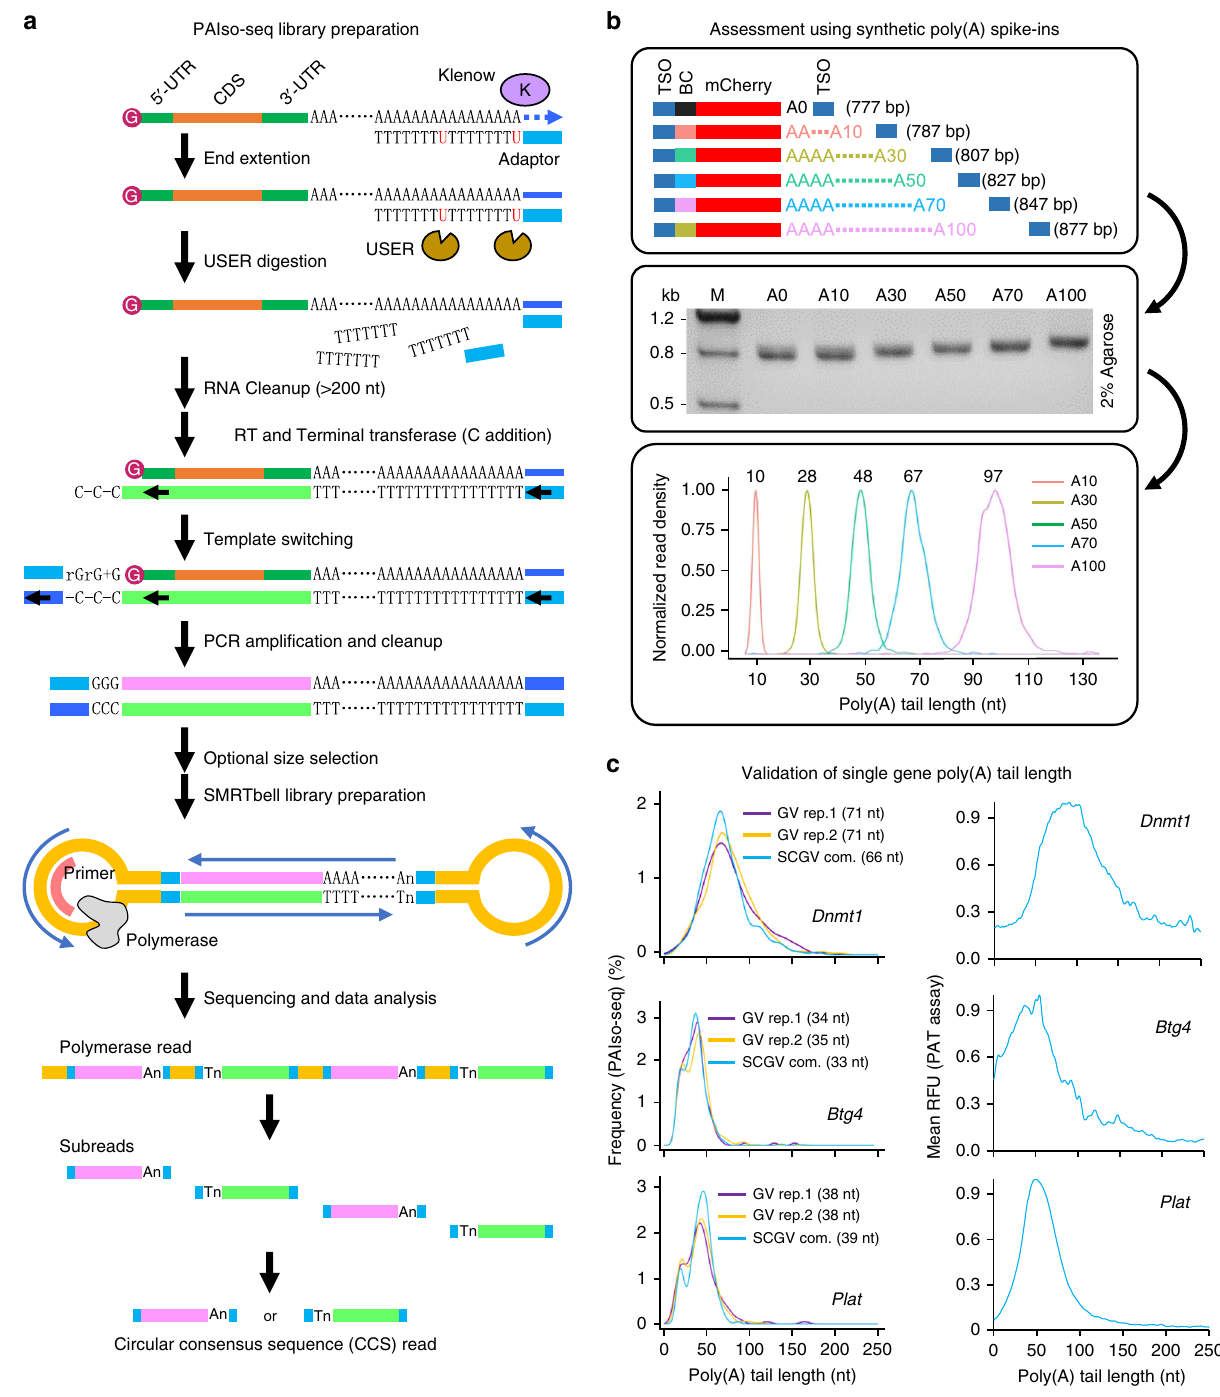
Fig. 1 The principle and validation of PAIso − seq. a Flowchart for PAIso − seq method design. The main steps of the method include end-extension, template-switching, full-length cDNA ampli fi cation, circular adaptor ligation, and PacBio sequencing. b The structure (top panel) and agarose gel analysis of the poly(A) spike-ins (middle panel). The mean poly(A) tail length of each spike-in measured by PAIso − seq (bottom panel). Source data are provided as a Source Data fi le. c The poly(A) tail lengths of Dnmt1 , Btg4 , and Plat in GV oocytes measured by PAIso − seq (density plot of poly(A) tail length of detected CCS reads of the given genes, three replicates, left panel) and PAT assay by using capillary electrophoresis on fragment analyzer (mean of three replicates, right panel). The mean length of each gene poly(A) tail measured by PAIso − seq is shown. The number of CCS reads used are 141 ( Dnmt1/ GV rep.1), 249 ( Dnmt1/ GV rep.2), and 165 ( Dnmt1/ SCGV com.); 164 ( Btg4/ GV rep.1), 521 ( Btg4/ GV rep.2), and 357 ( Btg4/ SCGV com.); 136 ( Plat/ GV rep.1), 277 ( Plat/ GV rep.2), and 207 ( Plat/ SCGV com.). The average length of poly(A) tails are 74 nt ( Dnmt1 ), 44 nt ( Btg4 ), and 45 nt ( Plat ) measured by the PAT assay. RFU, relative fl uorescence